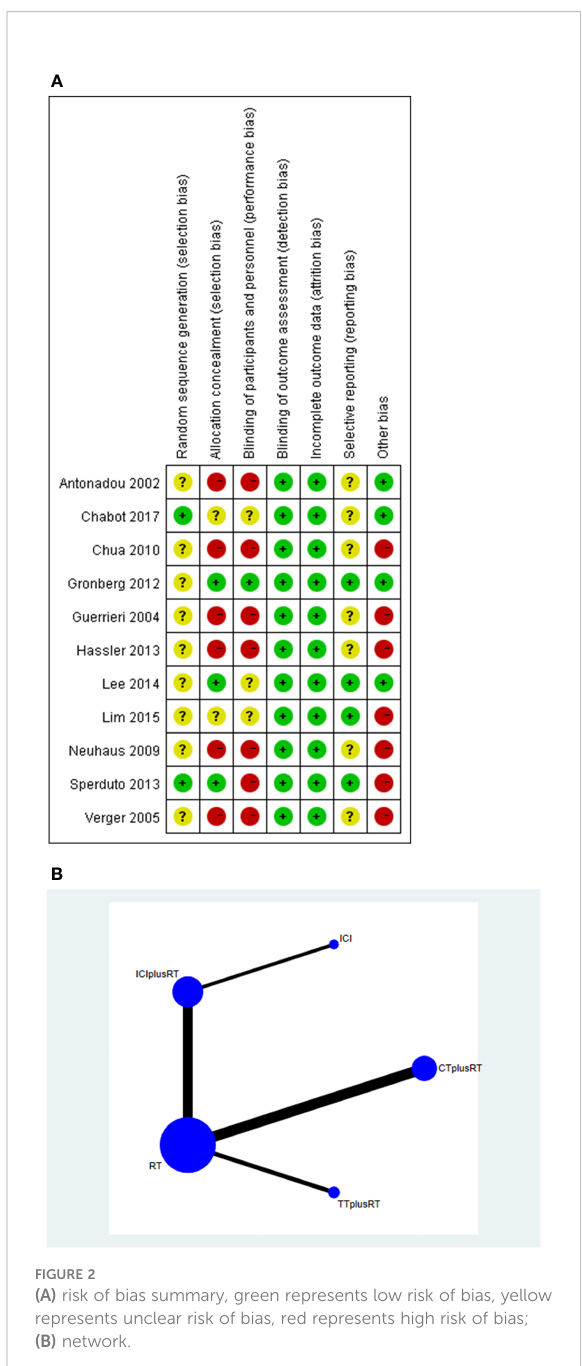
FIGURE 2 (A) risk of bias summary, green represents low risk of bias, yellow represents unclear risk of bias, red represents high risk of bias; (B)